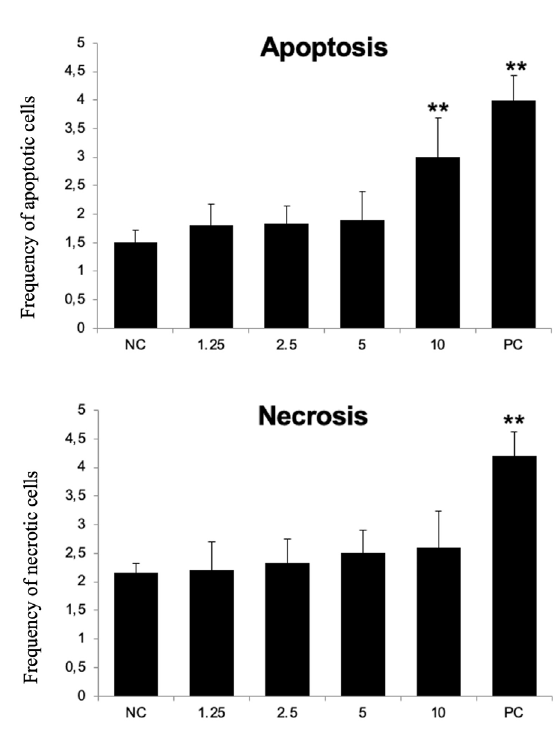
Figure 1. Effects of STX on the induction of apoptotic and necrotic cells. Cultured SHSY-5Y cells were exposed to different concentrations (1.25 – 10 µg/L) of STX for 24 h. **Significantly different from the negative control (NC) (p < 0.01). PC: positive control (Bleomycin 3